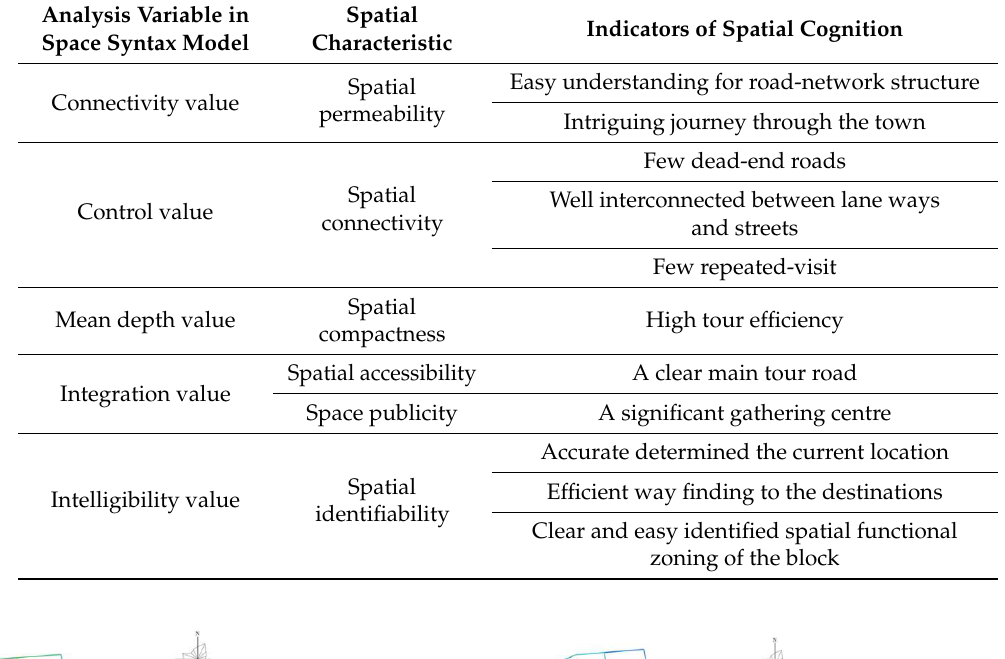
Table 4. Analysis variables in space syntax model and indicators of spatial cognition.